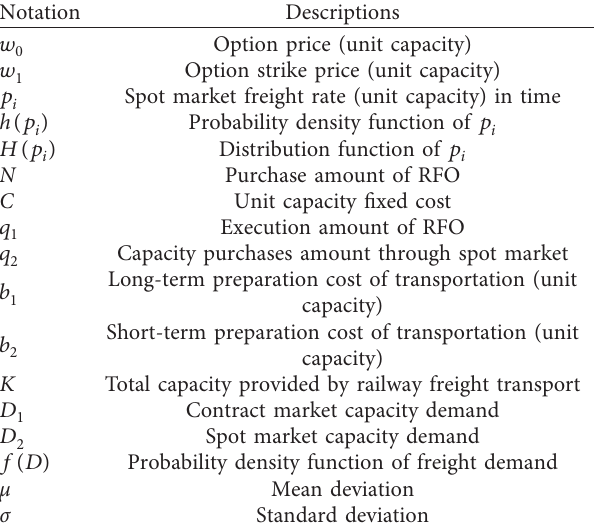
Figure 2: The transaction process of RFO. Table 1: Summary of